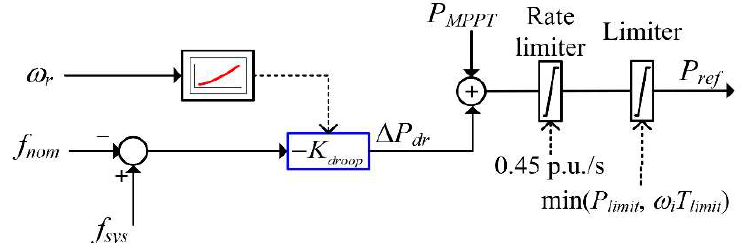
Figure 6. Structure of conventional scheme #2.